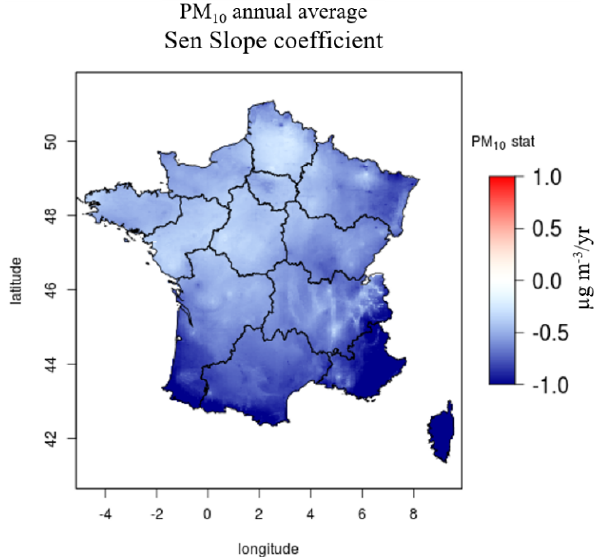
Figure 10. Trends in PM 10 annual mean concentration. Sen slope coefficient (µgm − 3 yr − 1 ) calculated over the period 2000–2015.